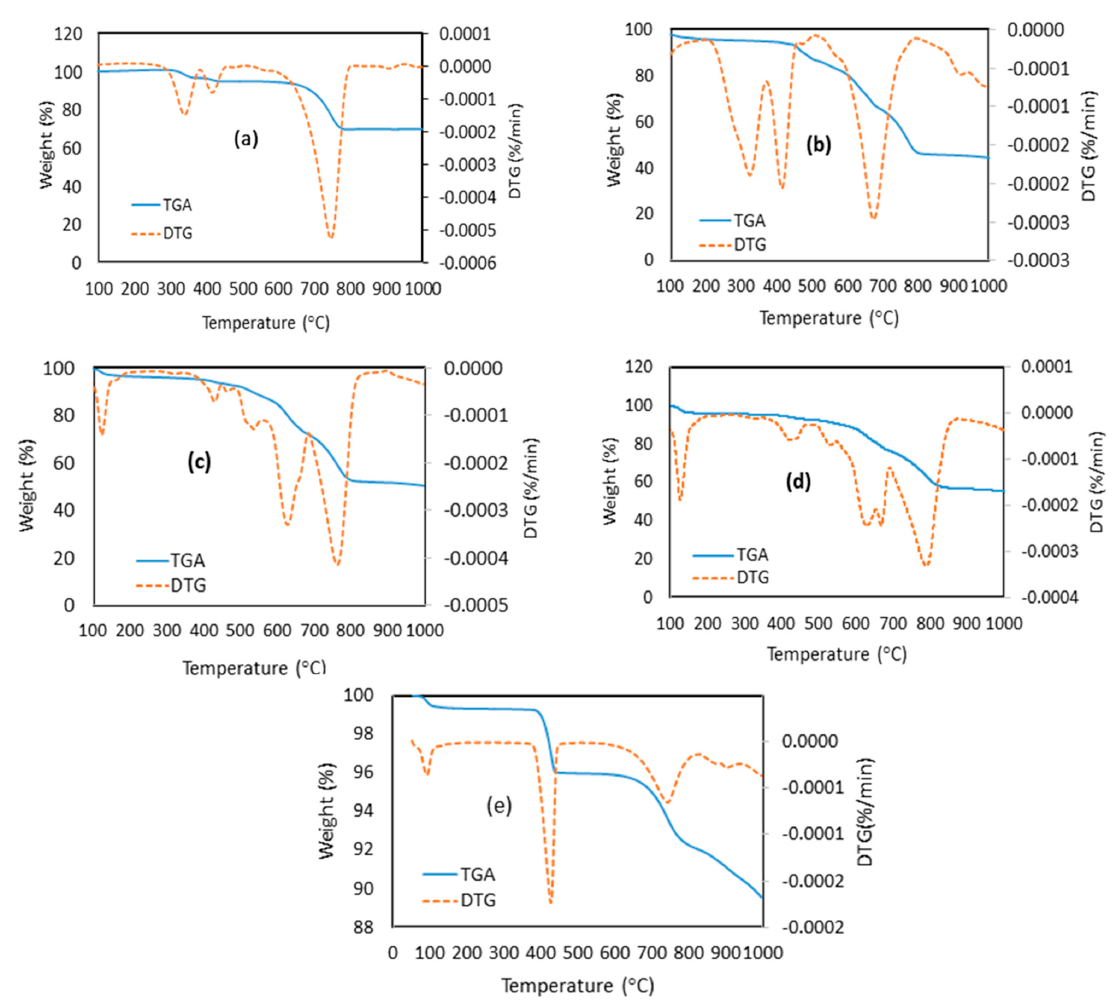
Figure 7. TGA-DTG thermogram of ( a ) Dolomite ( b ) 5 wt% K/D ( c ) 10 wt% K/D ( d ) 15 wt% K/D ( e ) 20 wt% K/D.